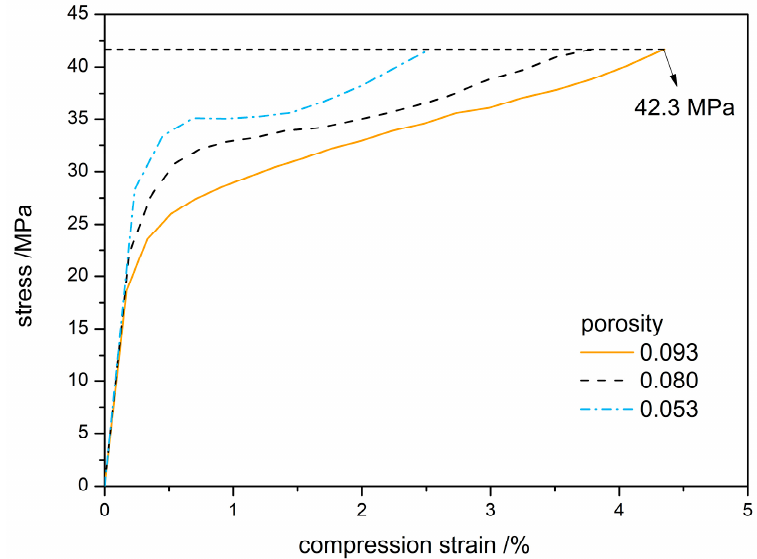
ff erent porosity Figure 7. Stress-strain curve of PBX at different porosity levels. Figure 7. Stress-strain curve of PBX at di Figure 7. Stress-strain curve of PBX at different porosity levels.